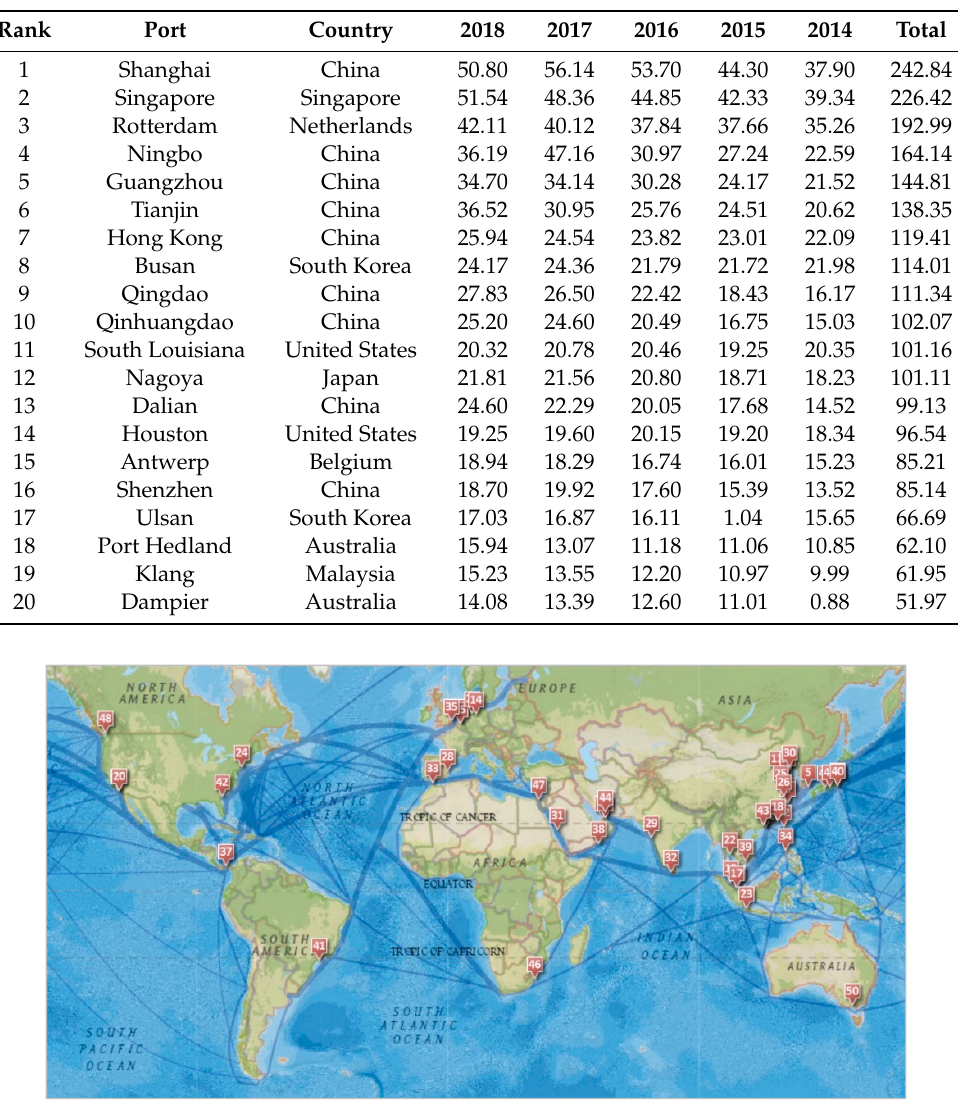
Table 4. Top 20 foreign ports by five-year total freight weight (billion tons), 2014–2018.